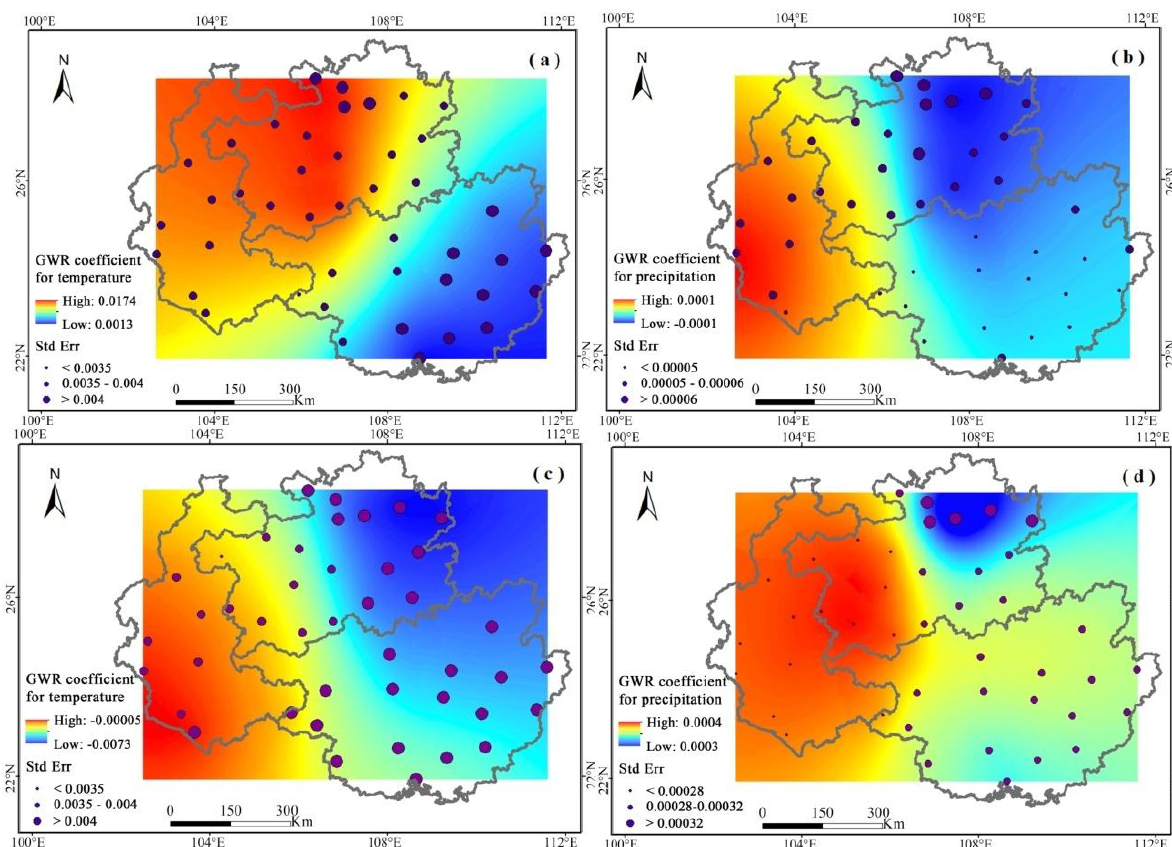
Figure 8. Geographically Weighted Regression analysis between NDVI and temperature and precipitation during 1982–2013. ( a ) coefficients image for temperature; ( b ) coefficients image for precipitation; ( c ) coefficients image for temperature trend; ( d ) coefficients image for precipitation trend. Figure 8a,b are static regression, and Figure 8c,d are dynamic regression. Std Err measures the reliability of each coefficient